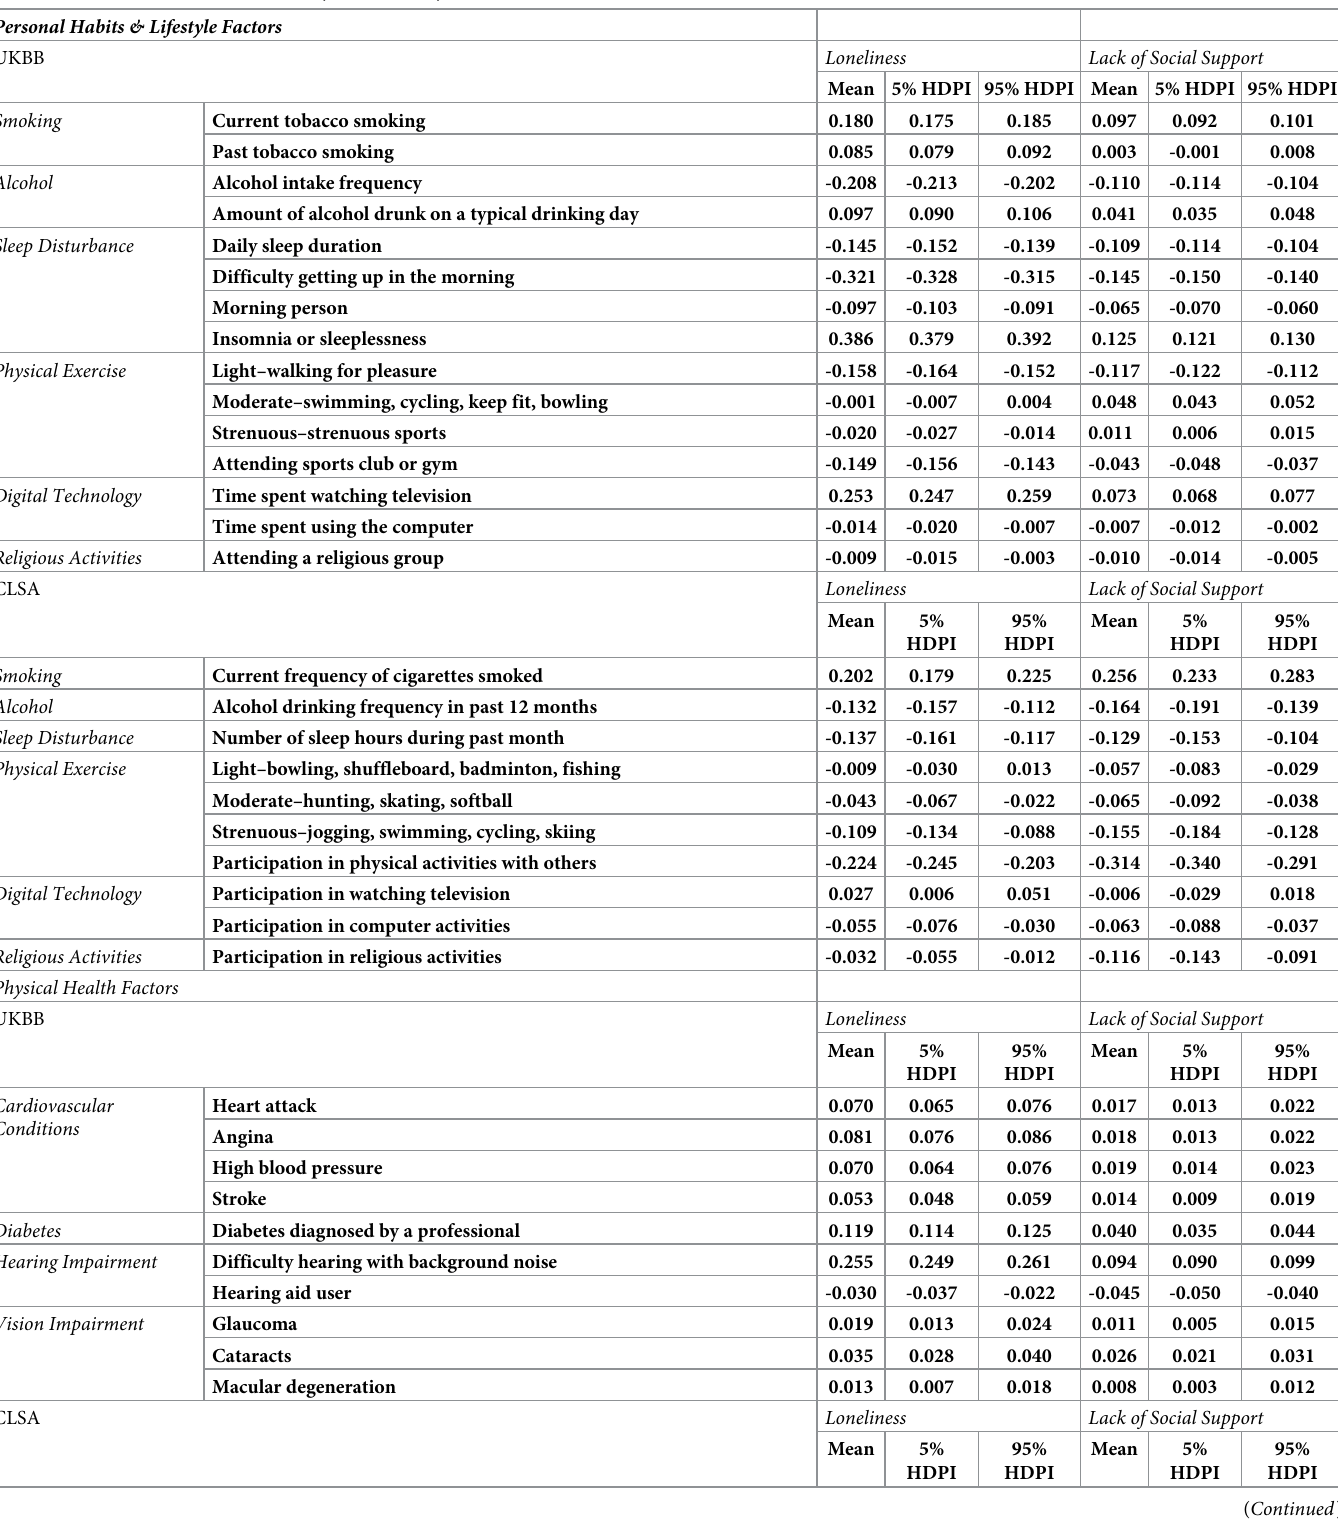
Table 1. Mean associations between subjective and objective social isolation and ADRD risk factors in the UKBB and the CLSA. Personal Habits & Lifestyle